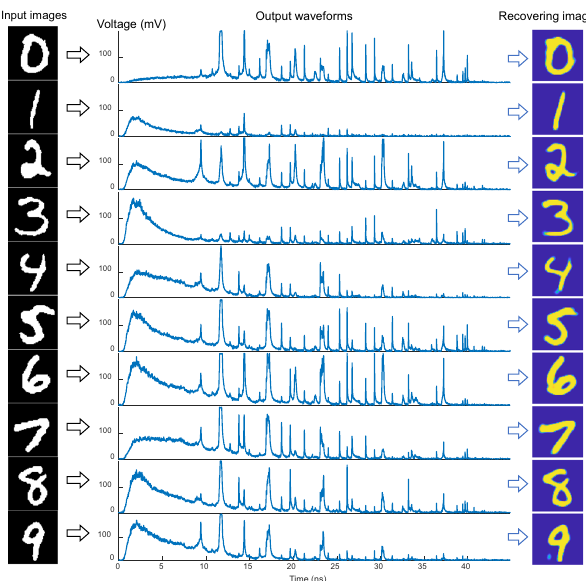
Fig. 3 Reconstruction process. The input images of digits 0 – 9 selected from the test database are transformed into output waveforms. Then the images are recovered from the